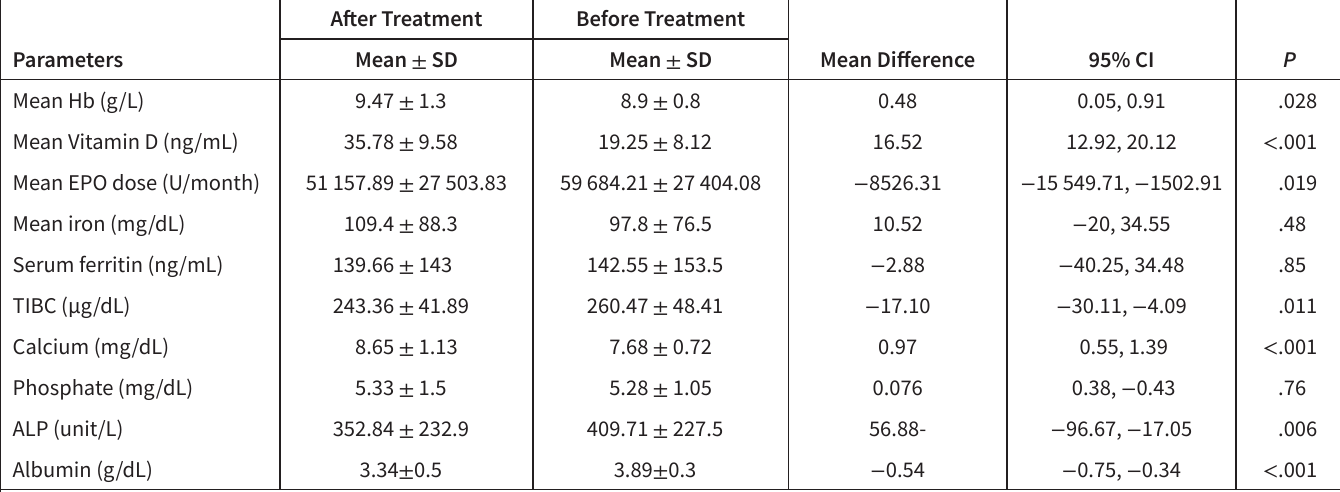
Table 1. Mean and Standard Deviation of Laboratory Parameters in Before and After 3 Months of Ergocalciferol Supplementation in Study Patient